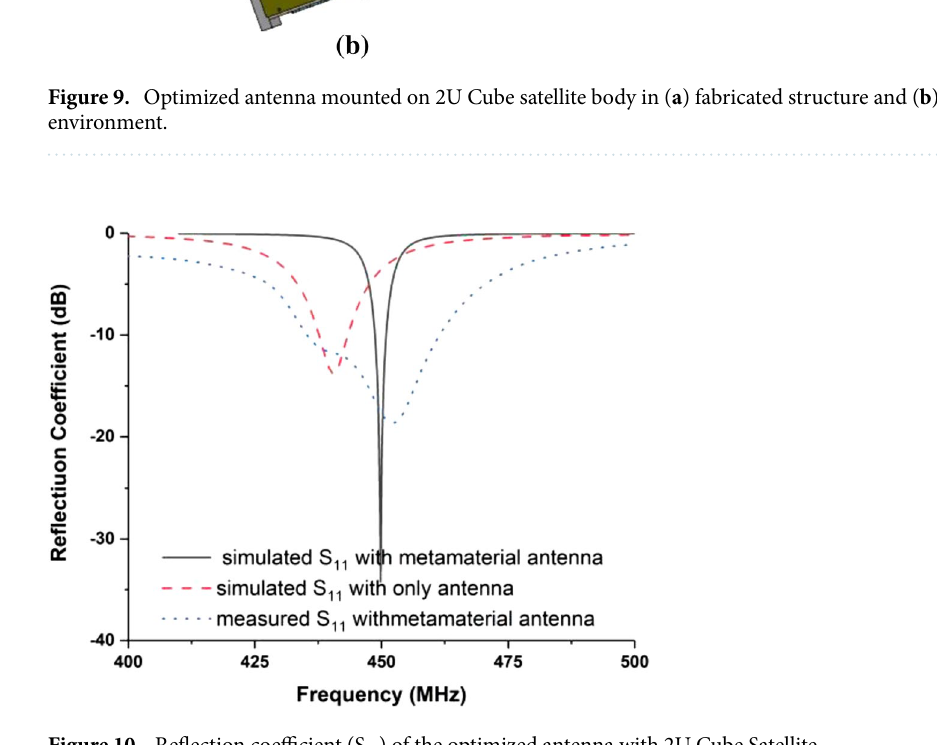
Figure 10. Reflection coefficient (S 11 ) of the optimized antenna with 2U Cube